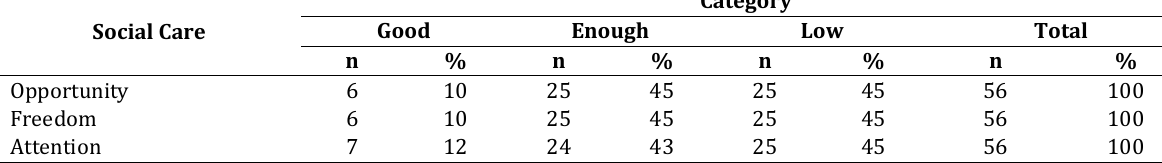
Table. 3 Social Care of Leprosy Patients in Probolinggo District